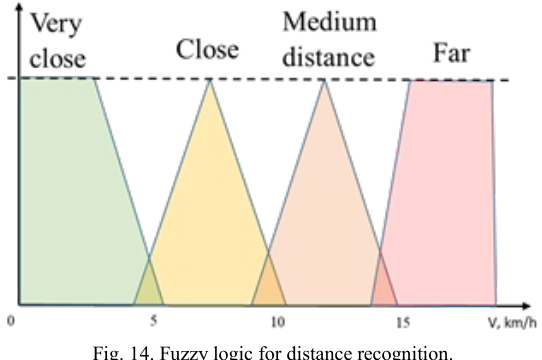
Fig. 14. Fuzzy logic for distance